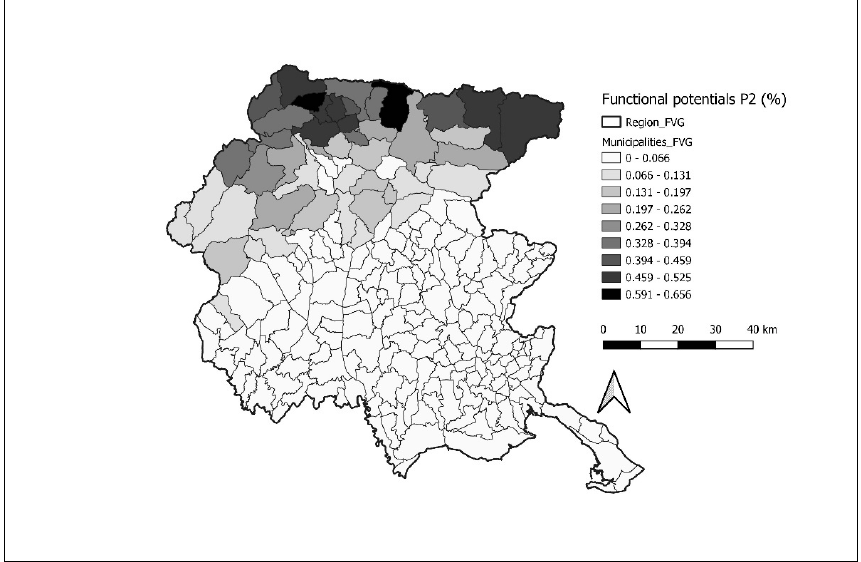
Figure 6. Potential respiratory benefits of BVOCs emitted by regional forests in mountain municipalities: Atomistic-segmentary approach (P2). Source: authors.